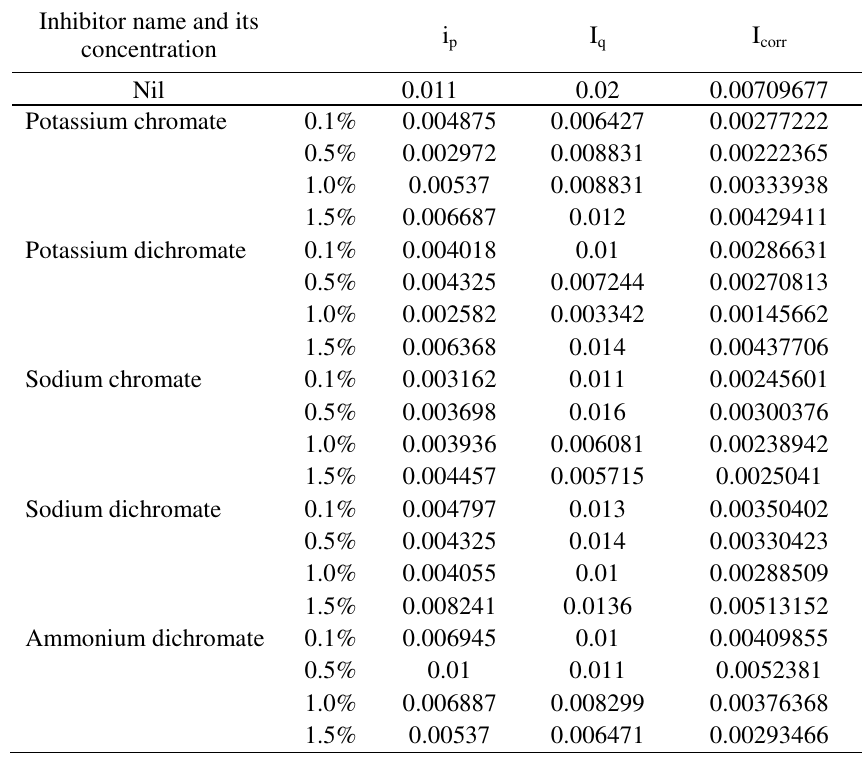
Table 2 . Effect of corrosion current density (I monochloroacetic acid in presence of chromates and